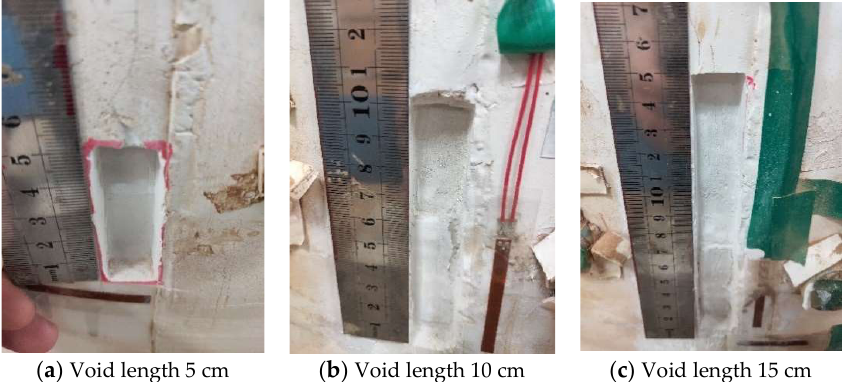
Figure 8. Vault void with different lengths.